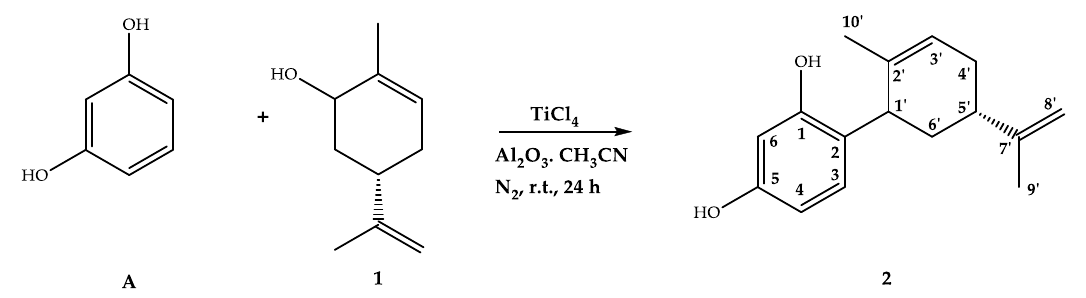
Scheme 1. Reaction scheme for carveoylphenol 2 synthesis.